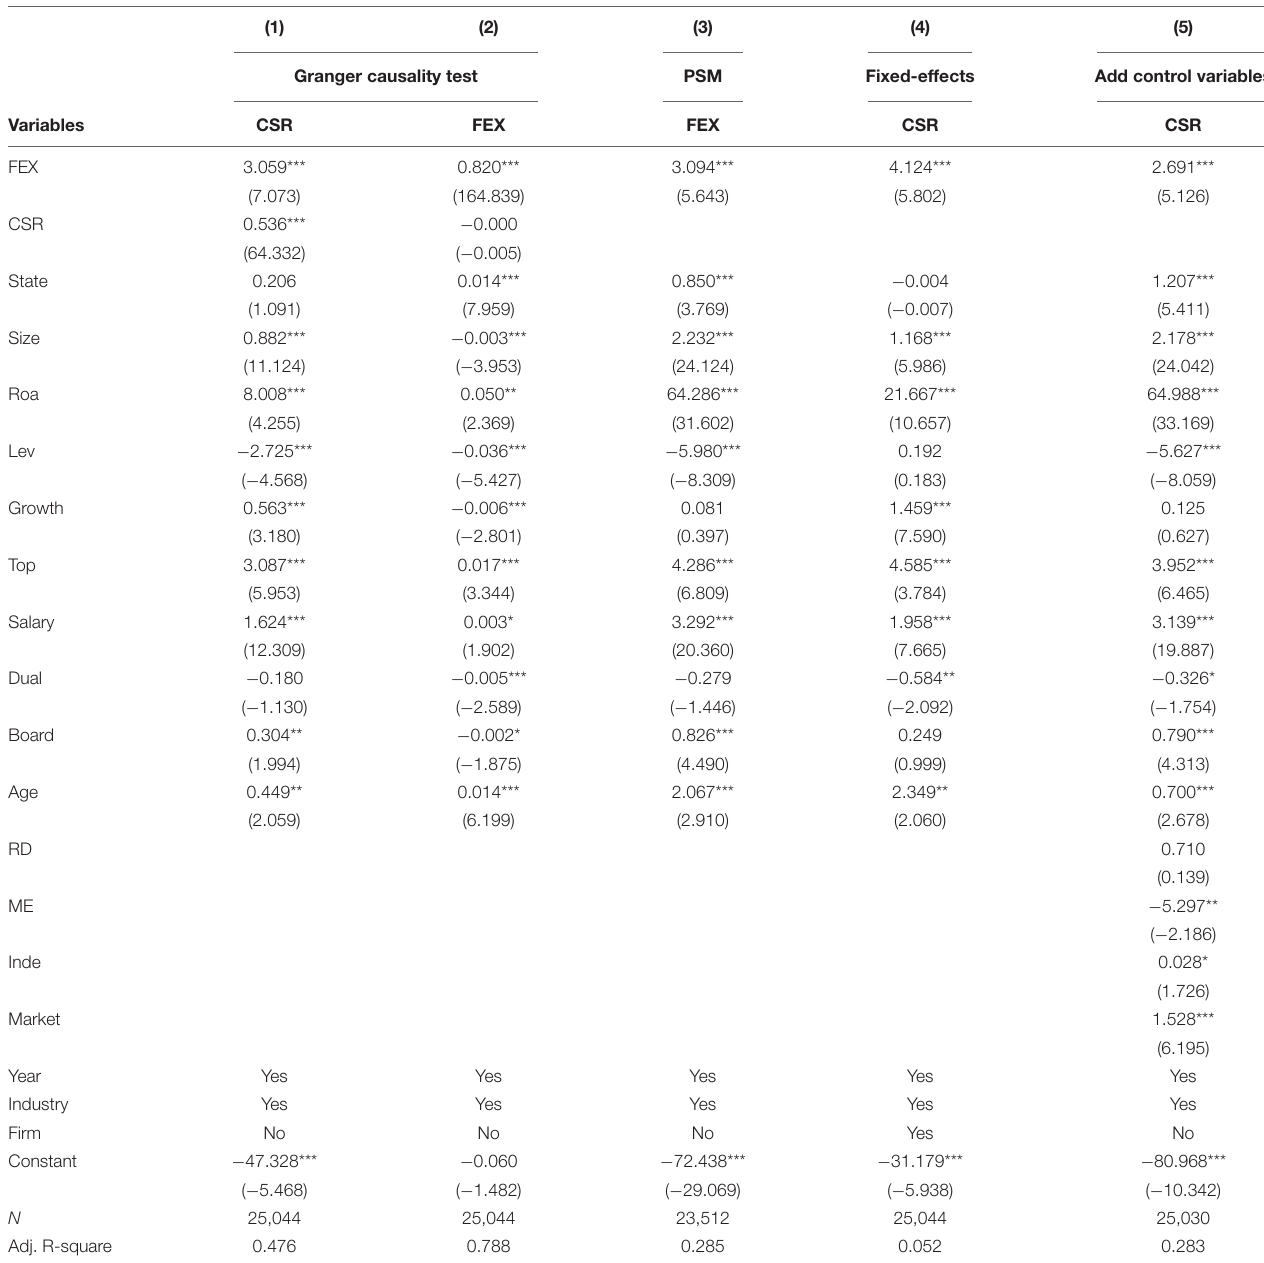
TABLE 7 | Endogeneity